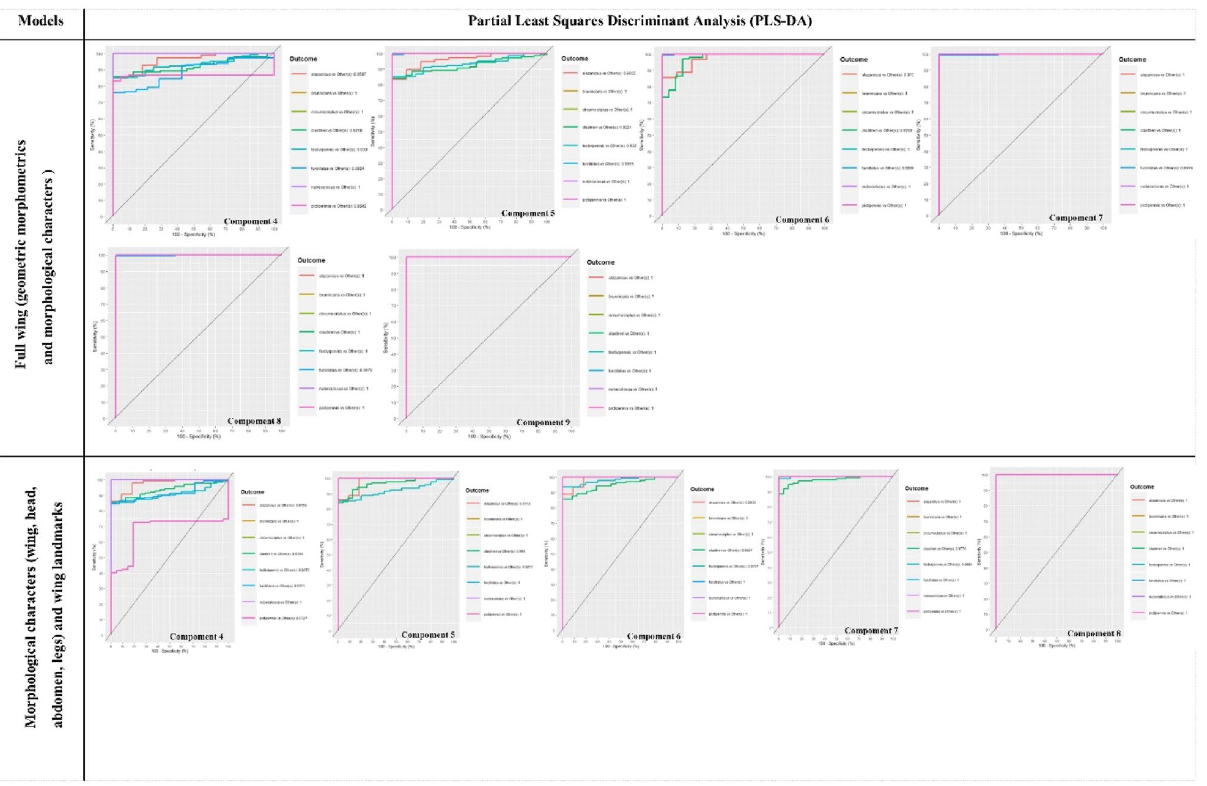
Figure 5. The ROC curve of the “ Full wing ” and “ Full model ” obtained with partial least squares discriminant analysis (PLS-DA) according to the components. A perfect result would be an area under the curve (AUC) of 1.0.